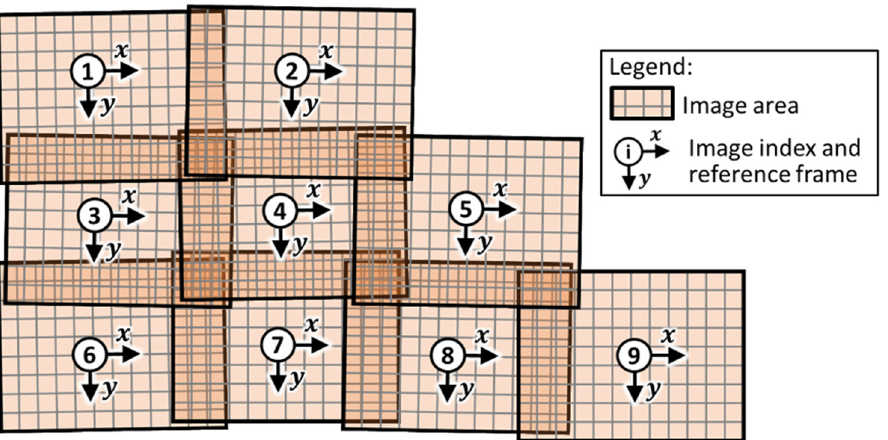
Figure 2. Schematic representation of a set of nine images used to explain the theoretical foundations of FiPAM. of